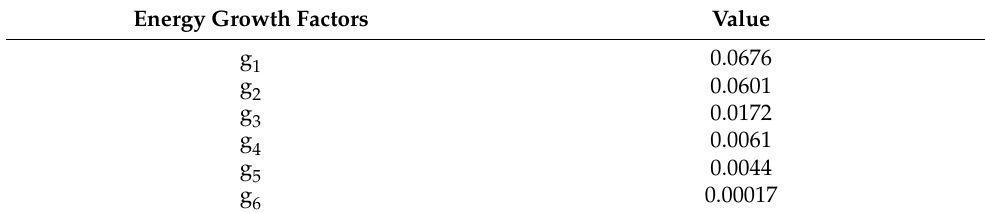
Figure 7. Time − frequency domain waveform: ( a ) first ACSRS; ( b ) second ACSRS. Table 1. Energy growth